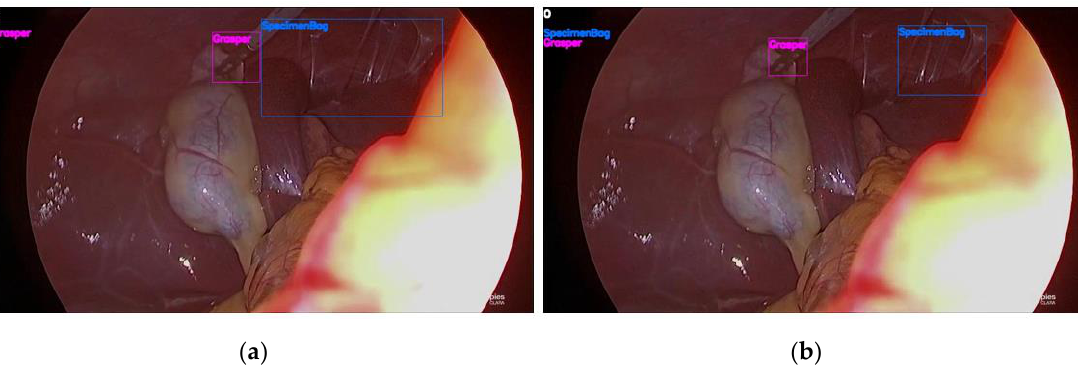
Figure 8. Example of errors in surgical tool detection using YOLO9000 and missing tool detection ( a ) The specimenbag was detected incorrectly in the previous frame, ( b ) The incorrectly detected specimenbag is judged as the missing tool, hence, it is redetected by applying the missing tool detection algorithm in the current frame.